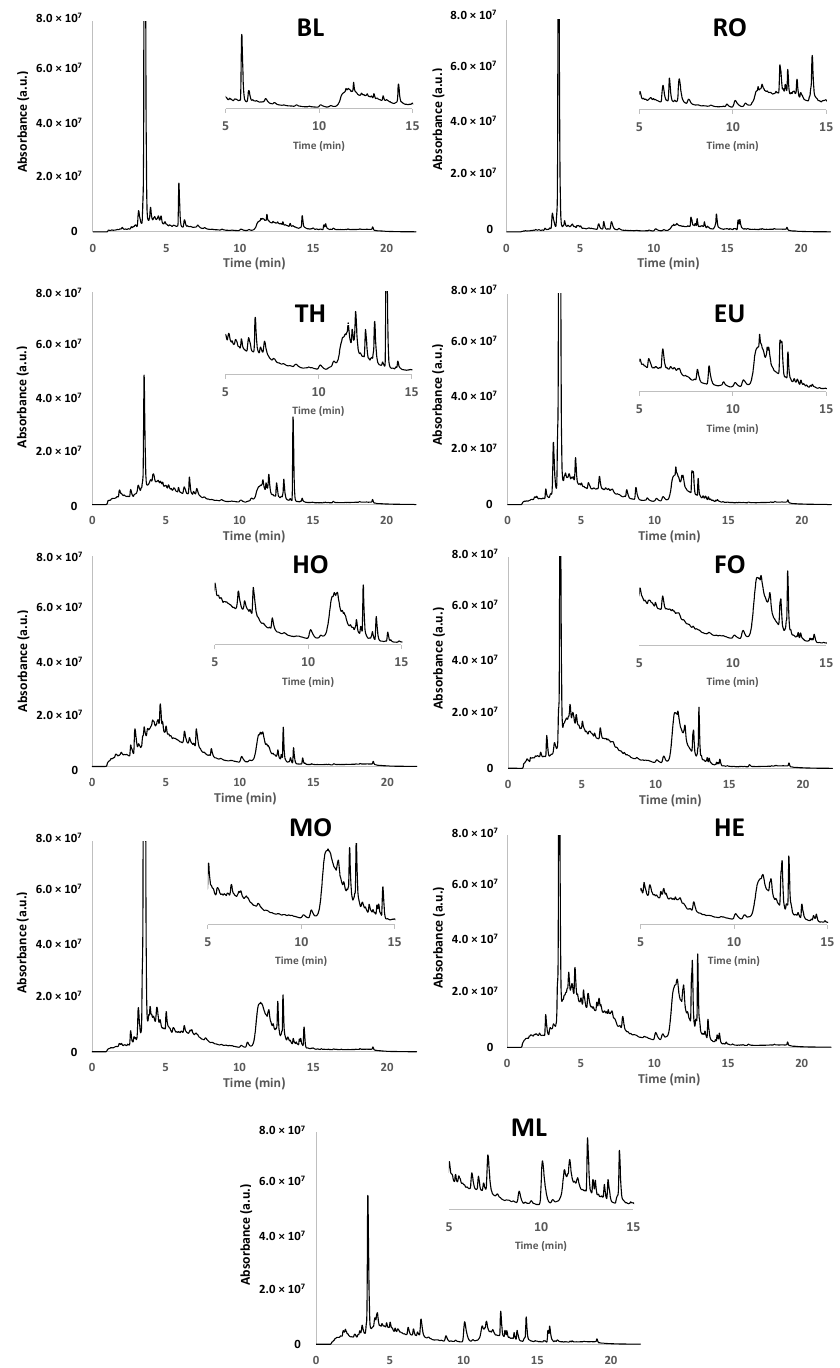
Figure 5. Off-line SPE HPLC-UV polyphenolic chromatographic fingerprints at 280 nm for one selected blossom and honeydew honey sample of each botanical origin under study. The time window from 5 to 15 min is enlarged in each inset. BL: Orange/lemon blossom; EU: Eucalyptus; FO: Forest; HE: Heather; HO: Holm oak; MF: Multifloral; MO: Mountain; RO: Rosemary; TH: Thyme.